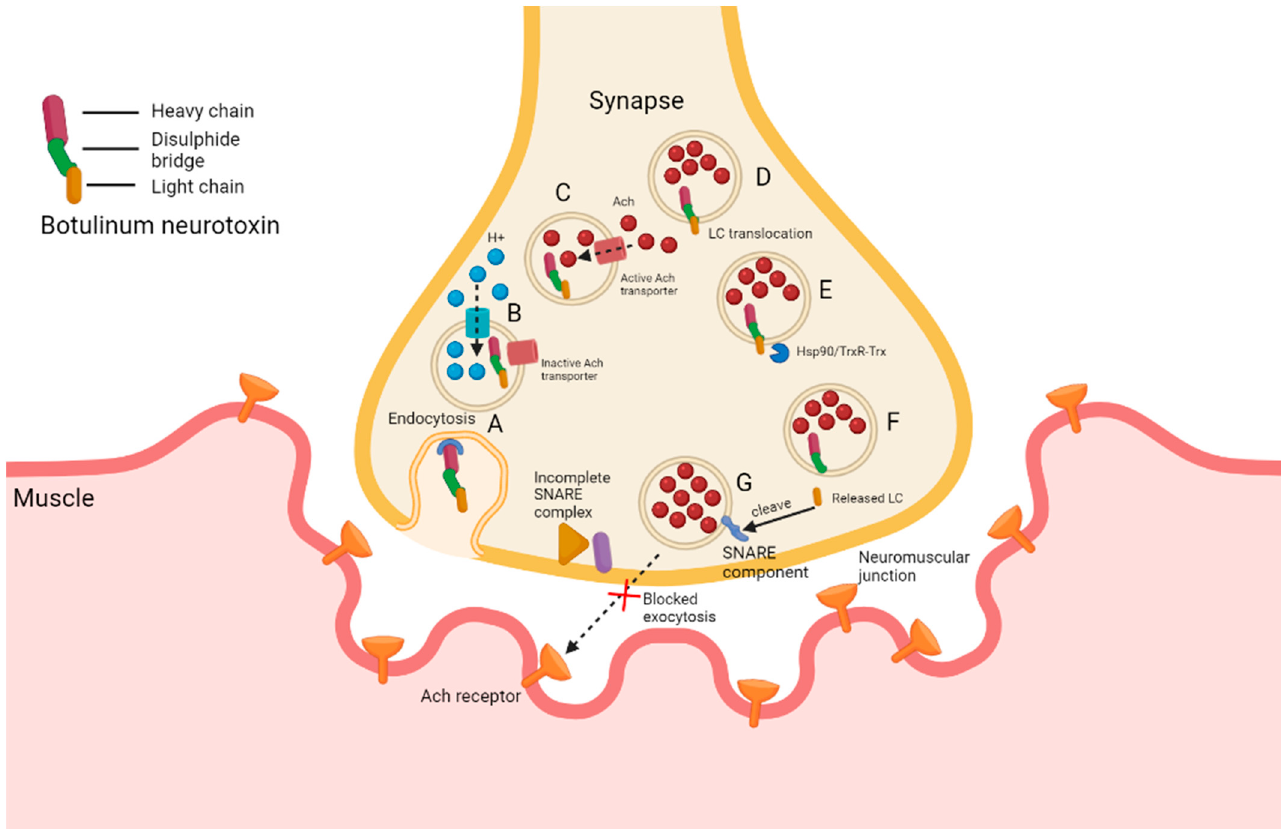
Figure 3. Botulinum neurotoxin (BoNT) mode of action. (A) BoNT binds to ecto-acceptors (polysialogangliosides) on the presynaptic cell surface of cholinergic neurons and is internalized via SV-2 or Syt-mediated endocytosis. (B) The synaptic vesicle is acidified with vesicular proton pumps, which in turn (C) activates Ach transporter proteins. The activated transporter proteins import acetylcholine (Ach) and the light chain (LC) of BoNT is translocated to the cytosol (D) with the heavy chain (HC) domain. (E) Heat shock protein 90 (Hsp90) and thioredoxin reductase-thioredoxin (TrxR-Trx) cleaves the LC and (F) liberates it into the cytosol. (G) The C-domain is a Zn 2+ -dependent endopeptidase that cleaves proteins in the soluble N-ethylmaleimide-sensitive adaptor receptor (SNARE) protein complex. This complex is responsible for exocytosis and the fusing of acetylcholine-containing vesicles with the plasma membrane, allowing the release of acetylcholine. The cleaved SNARE component is non-functional, thereby blocking the release of acetylcholine from the presynaptic membrane to muscles. Blocking exocytosis of acetylcholine leads to failed skeletal muscle contracture. This representation was constructed using BioRender (https://biorender.com/, ac- cessed on 12 May 2022).